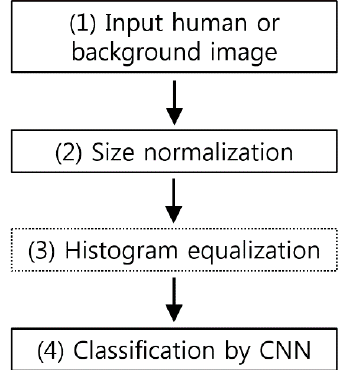
Figure 1. Flowchart of proposed method.